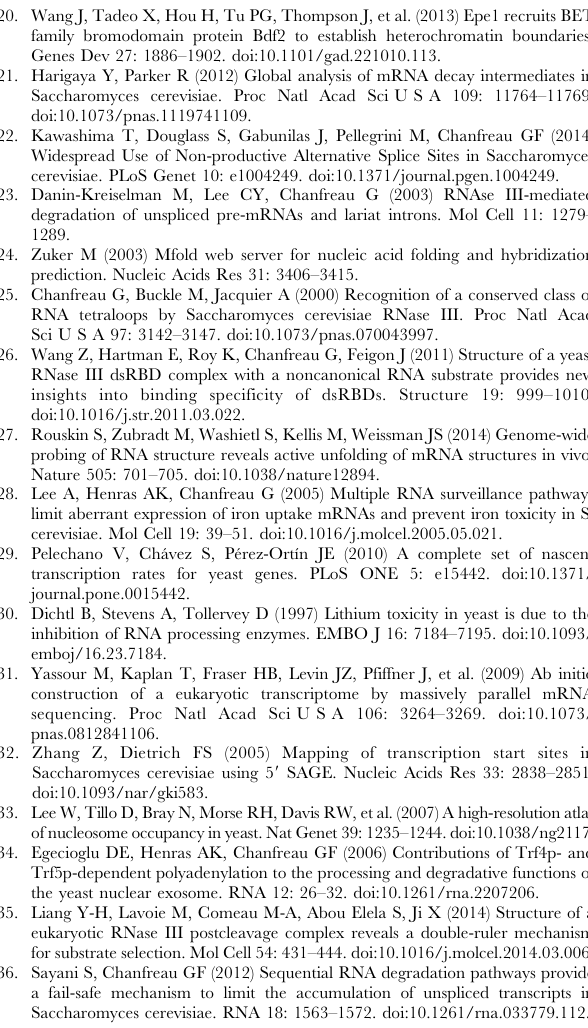
The BDF2-L full-length transcript and its RMD product were detected with the 5 9 -UTR probe that does not bind BDF2-S (bottom half). Figure S5 Wild-type and the specified BDF2 mutants were shifted to 0.6 M NaCl for the time points indicated. GLK1, HAL5, GRE3 , and LEU1 were detected with riboprobes targeting the open reading frames of their respective transcripts. SCR1 is a loading control. Figure S6 The wild-type strain and the specified BDF2 mutants were grown on plates with the indicated media at 30 u C for the indicated number of days. ( A ) Inactivation of RMD or SMD of BDF2 mRNA has no effect on the growth of the wild-type background in high salt or hyperosmotic stress conditions. ( B ) Inactivation of RMD or SMD of BDF2 mRNA confers sensitivity to 0.6 M lithium chloride, but not methyl methanesulfonate (MMS) or hydroxyurea (HU). ( C ) Cells lacking BDF2 are hyper- sensitive to 2% dimethyl sulfoxide (DMSO), and do not grow on the combination of 2% DMSO and 100 m M camptothecin (CPT).